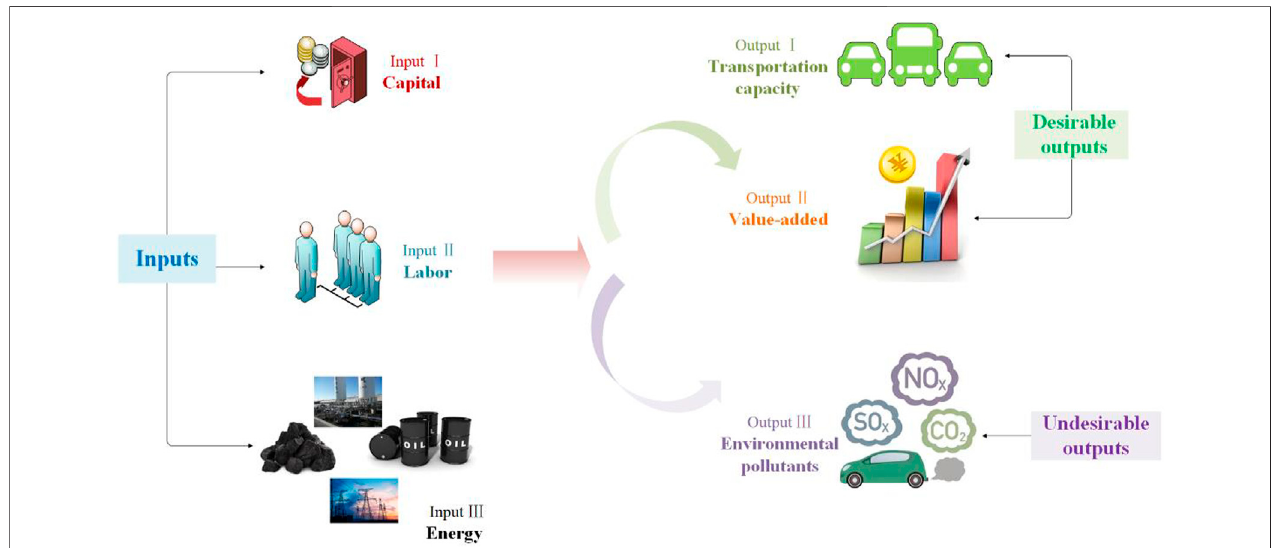
FIGURE 2 | The input and output dimensions of the transportation system